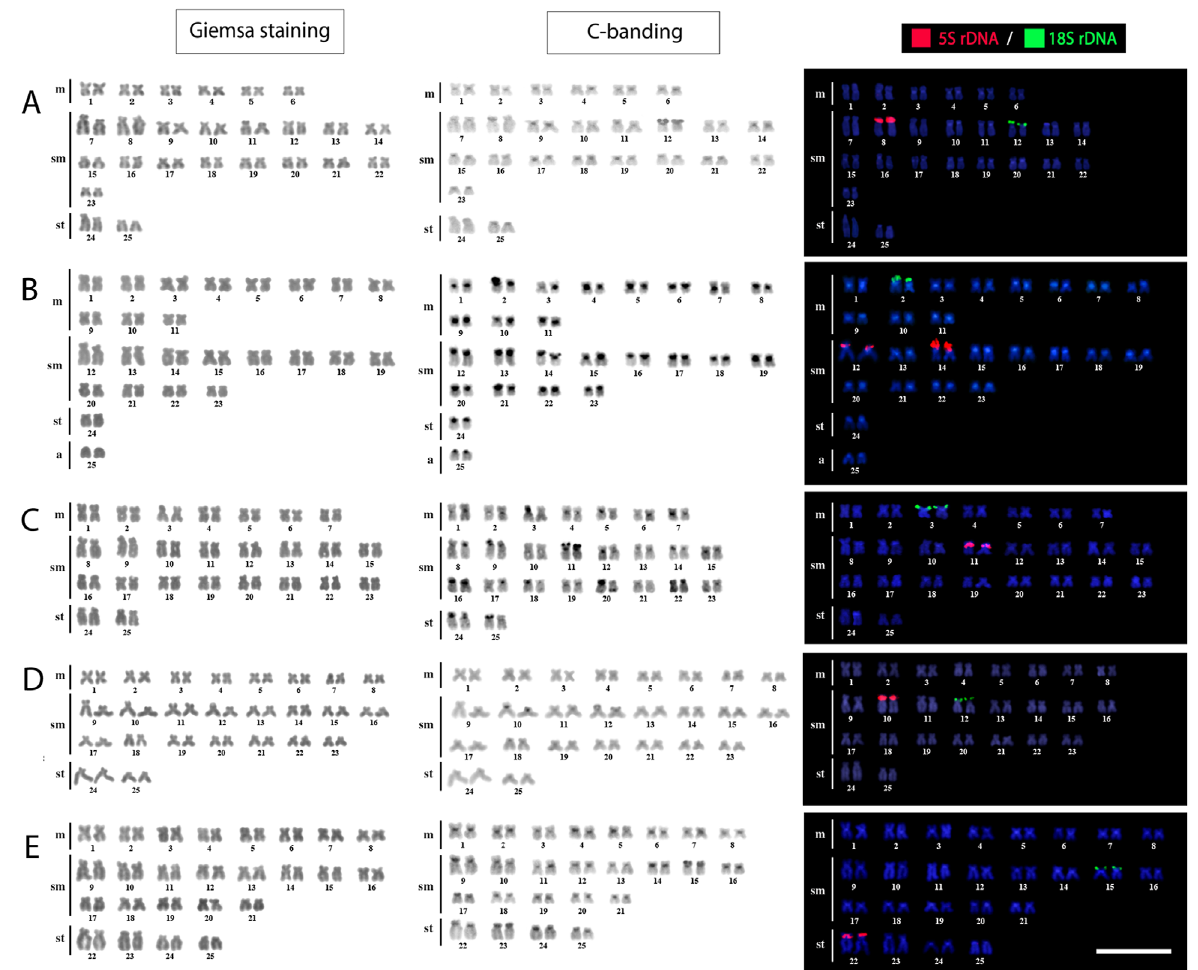
Figure 2 – Karyotypes of the Osteochilus species examined arranged from Giemsa- stained, C-banded chromosomes and chromosomes after FISH with 5S (red) and 18S (green) rDNA probes. A= O. lini ; B= O. melanopleura ; C= O. microcephalus ; D= O. vittatus; E= O. waandersi . Chromosomes were counterstained with DAPI (blue). Scale bar = 5